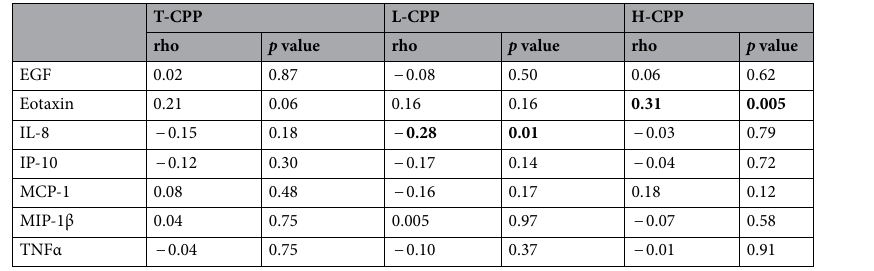
Table 2. bivariate correlations expressed as rho correlations of EGF, Eotaxin, IL-8, IP-10, MCP-1, MIP-1β and TNFα with CPPs at baseline in 78 HD patients. Signigficant values are in bold. T-CPP total calciprotein particle; L-CPP low density calciprotein particle; H-CPP High density calciprotein particle; EGF epidermal growth factor; IL- interleukin-; IP-10 Interferon gamma-induced protein 10 (C-X-C motif chemokine